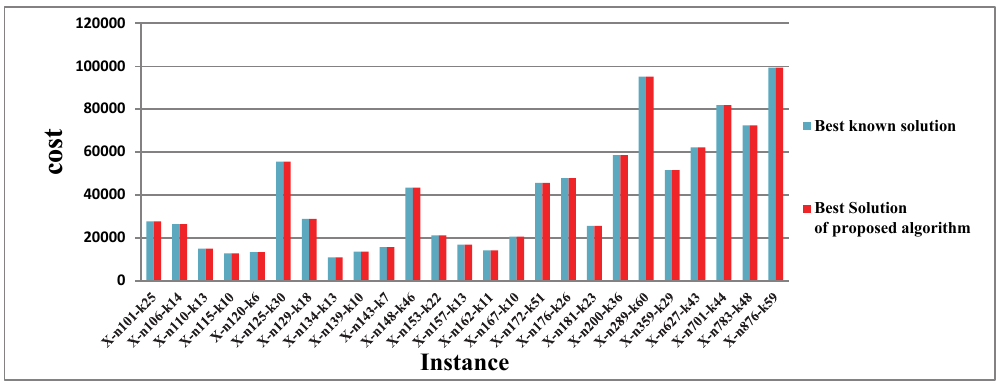
Fig. 2. Graphical representation of Table 4